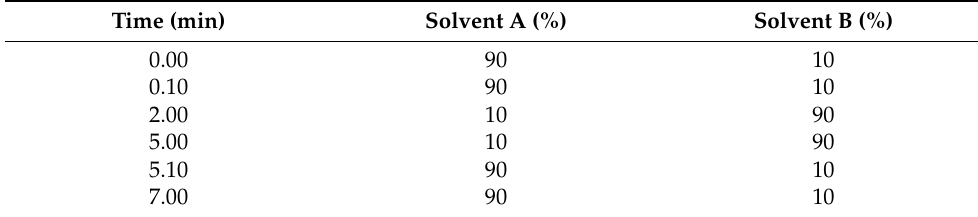
Table 3. Solvent Gradients for HPLC–MS-MS